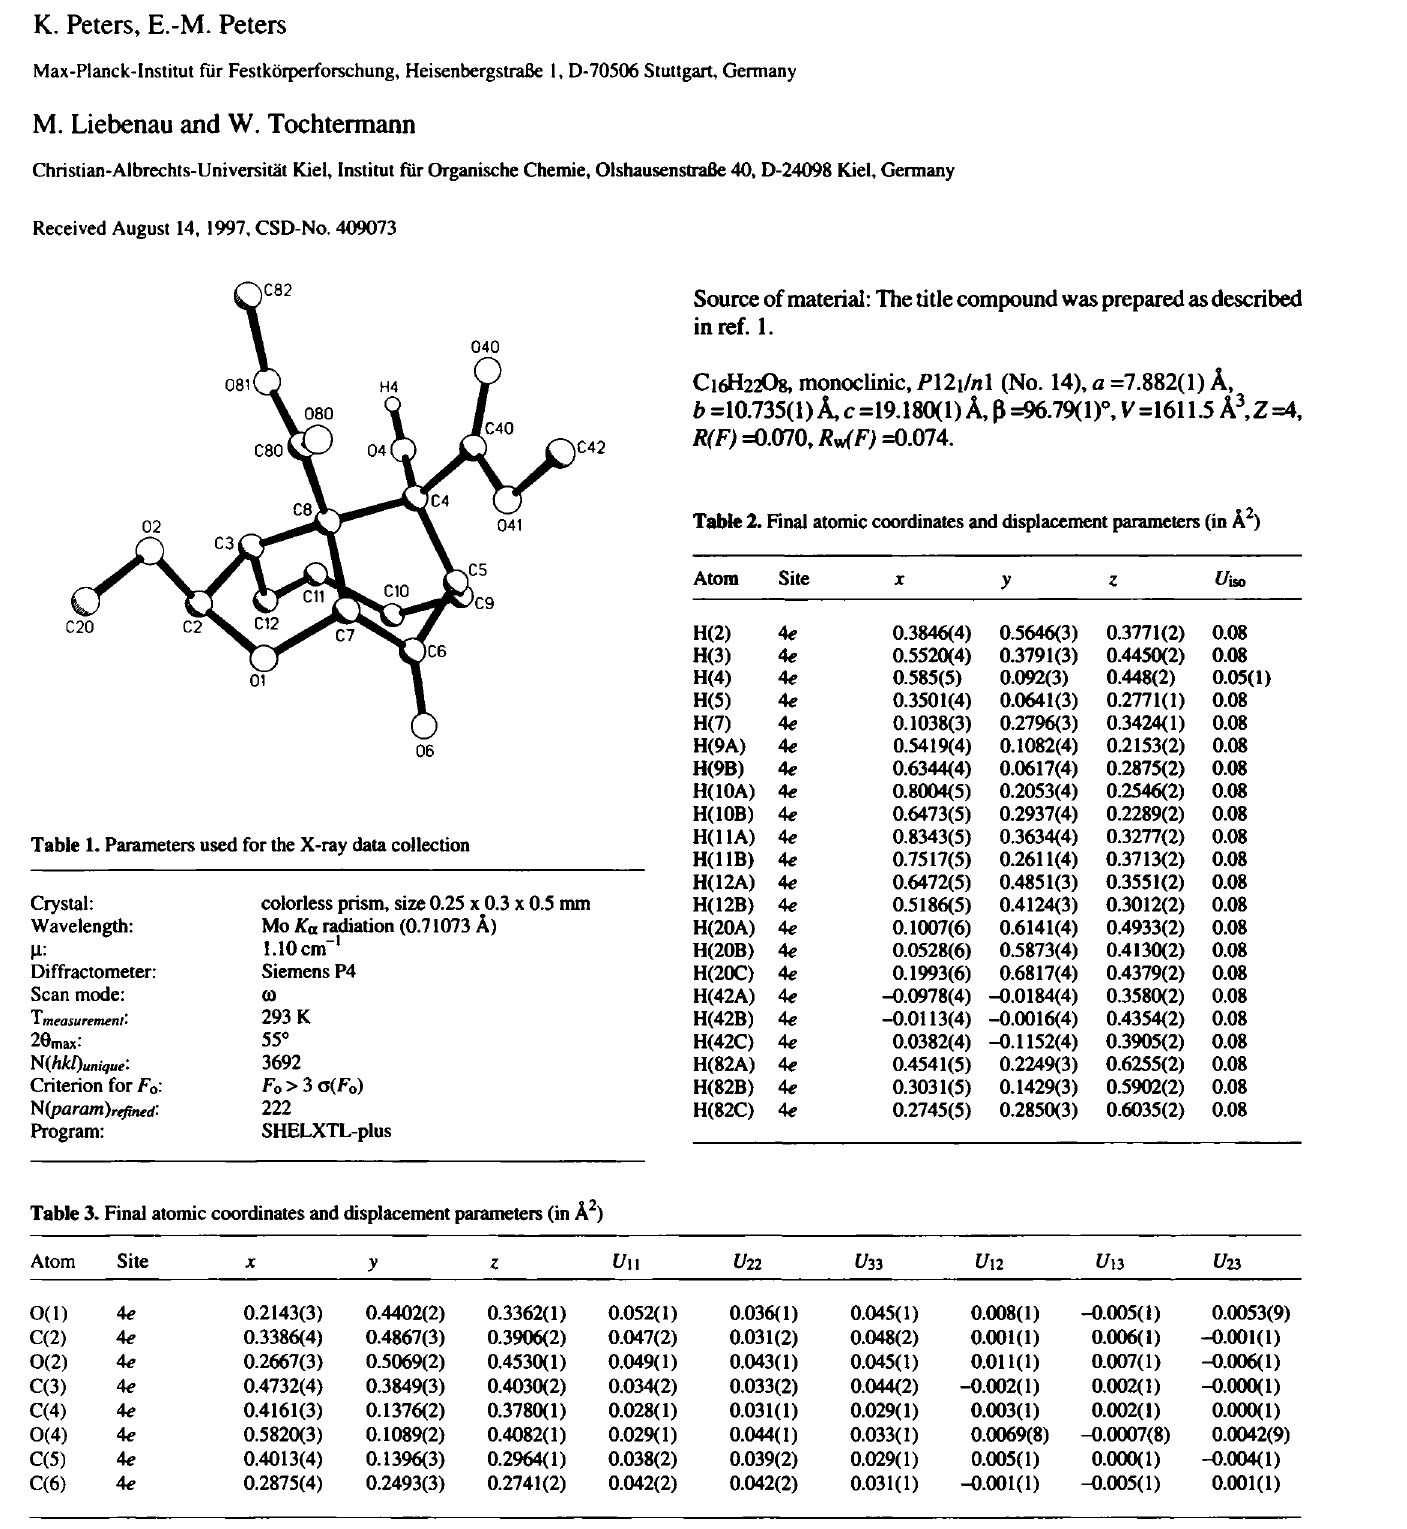
Source of material: The title compound was prepared as described inref. 1.